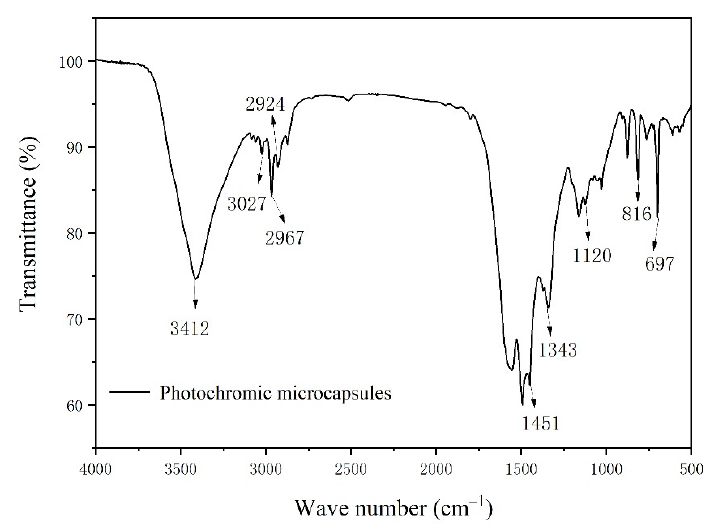
Figure 5. FTIR image of the photochromic microcapsules.